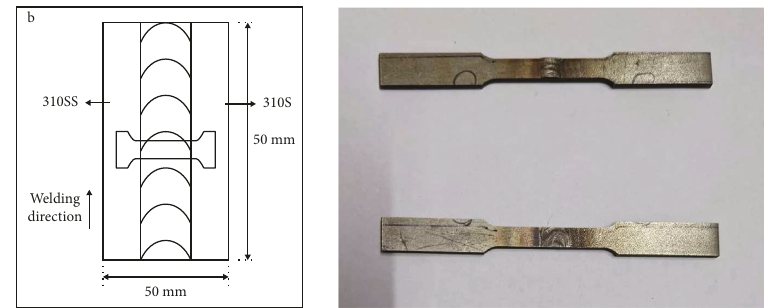
Figure 7: Specimens for the tensile test.